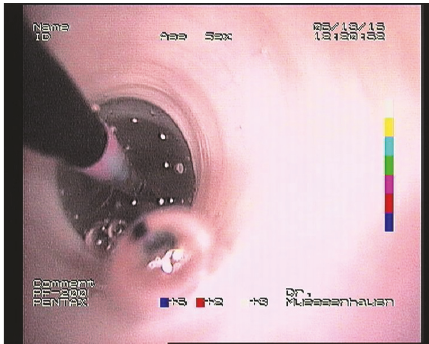
Figure 5: Endoscopic view of the esophagus immediately after balloon dilation. Slight hemorrhage can be observed.